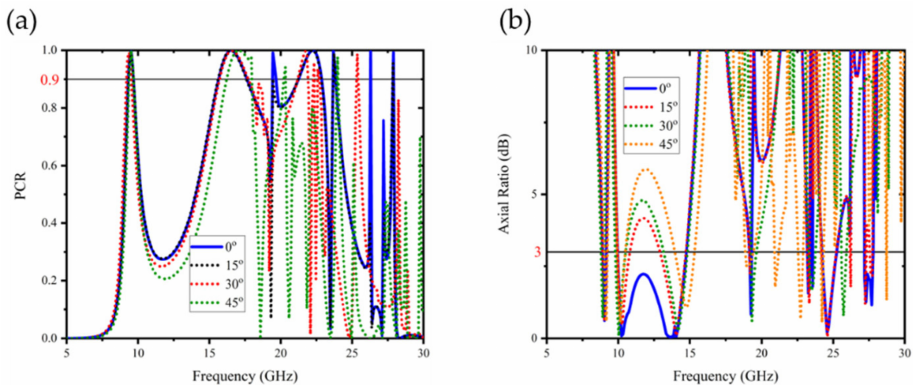
Figure 4. Polarization conversion at oblique incidence: ( a ) PCR and ( b )